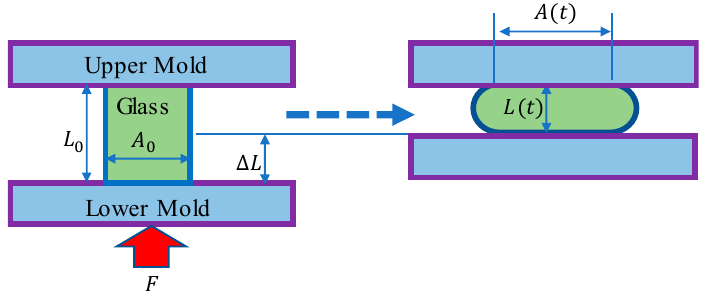
Figure 1. Illustration of creep compression.